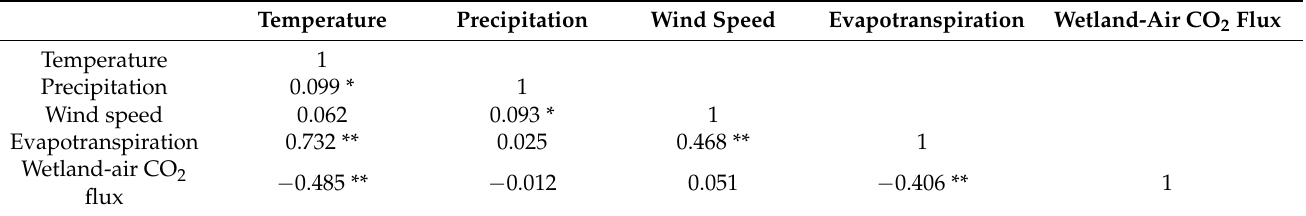
Table 1. Correlation coefficients between the wetland-air CO 2 fluxes and the meteorological fac- tors.